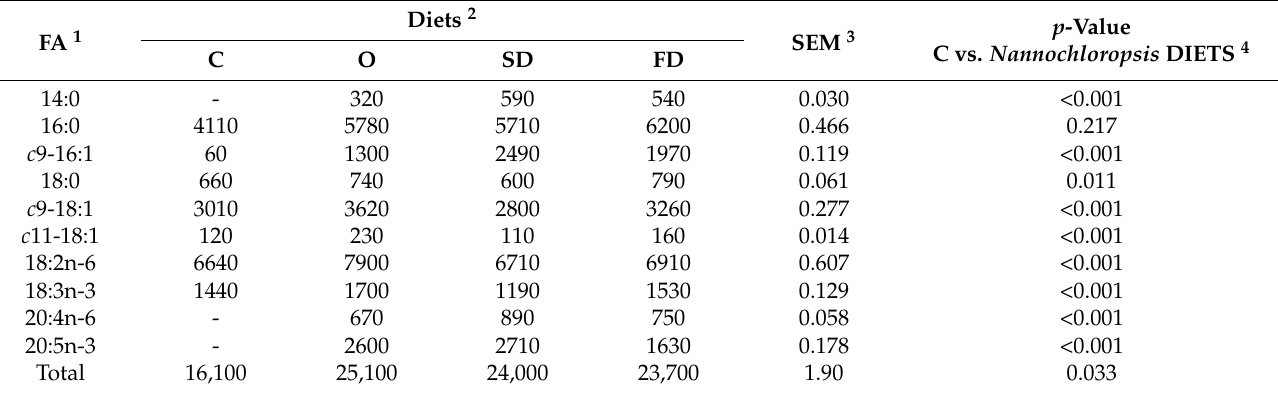
Table 2. Daily fatty acid (FA) intake (m/day) during the